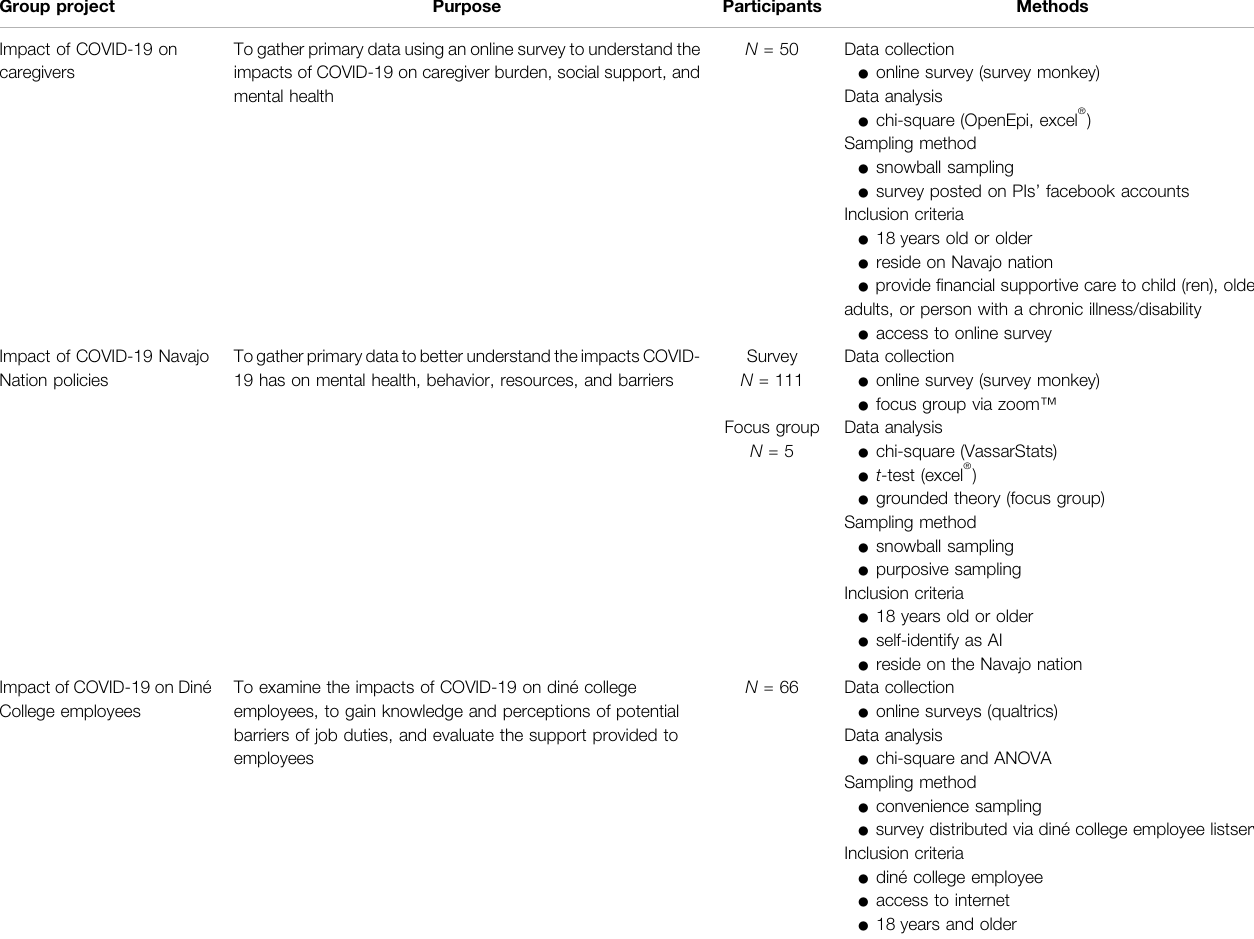
TABLE 3 | Summer Research Enhancement Program student COVID-19